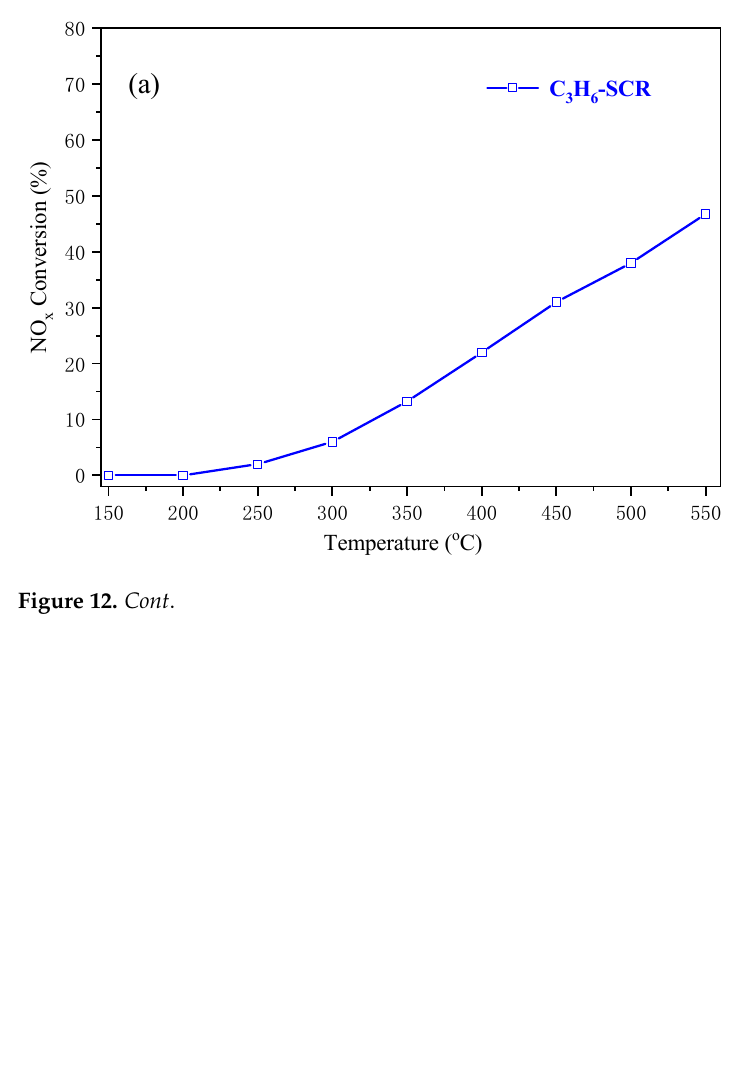
Figure 11. The DRIFTS spectra of saturated NH 3 titration by ( a ) NO + O 2 , and ( b ) NO + C 3 H 6 + O 2 over Cu-SAPO-34 at 200 °C.